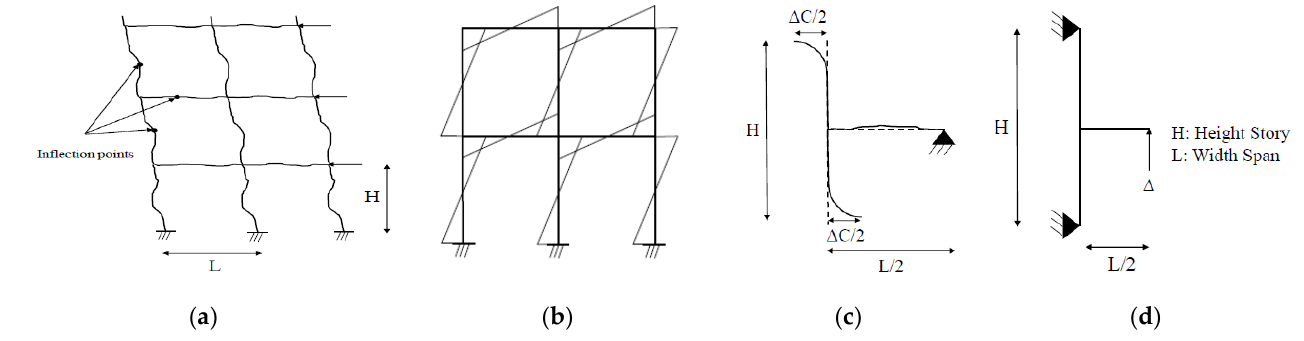
Figure 2. MRF under cyclic loading. ( a ) The MRF deflection diagram of the MRF, ( b ) moment diagram, ( c ) exterior connection, and ( d ) installed substructure in numerical modeling, reproduced with permission of Gerami et al. [43].